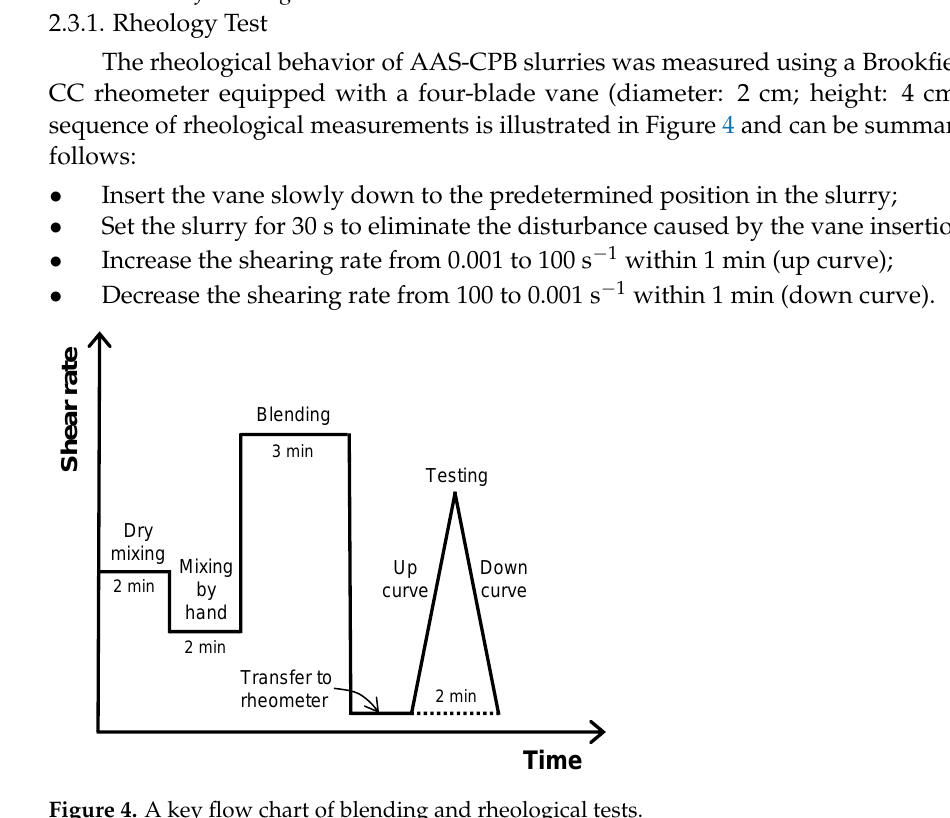
Figure 4. A key flow chart of blending and rheological tests.